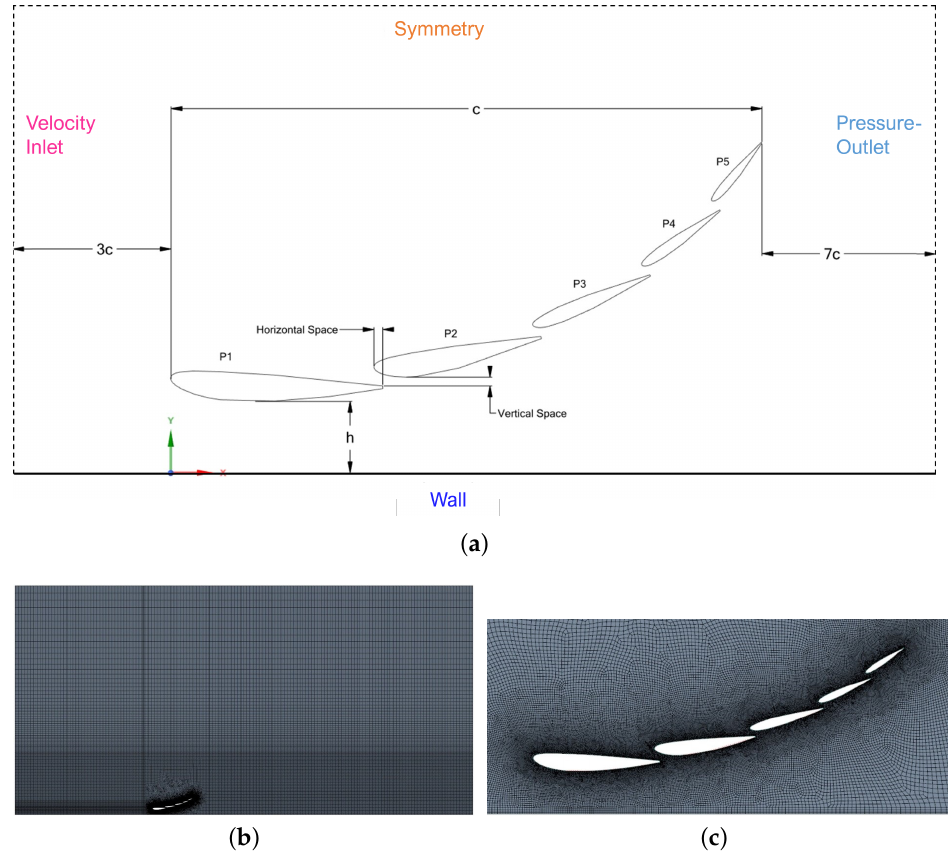
Figure 3. Sketch of ( a ) computational domain including boundary conditions, ( b ) computational grid, and ( c ) detail of computational grid around the front